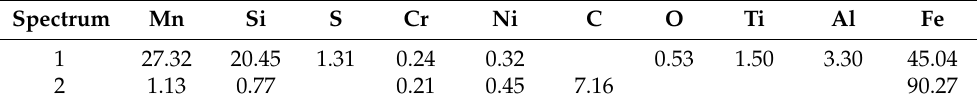
Table 4. EDS results (weight (%)).